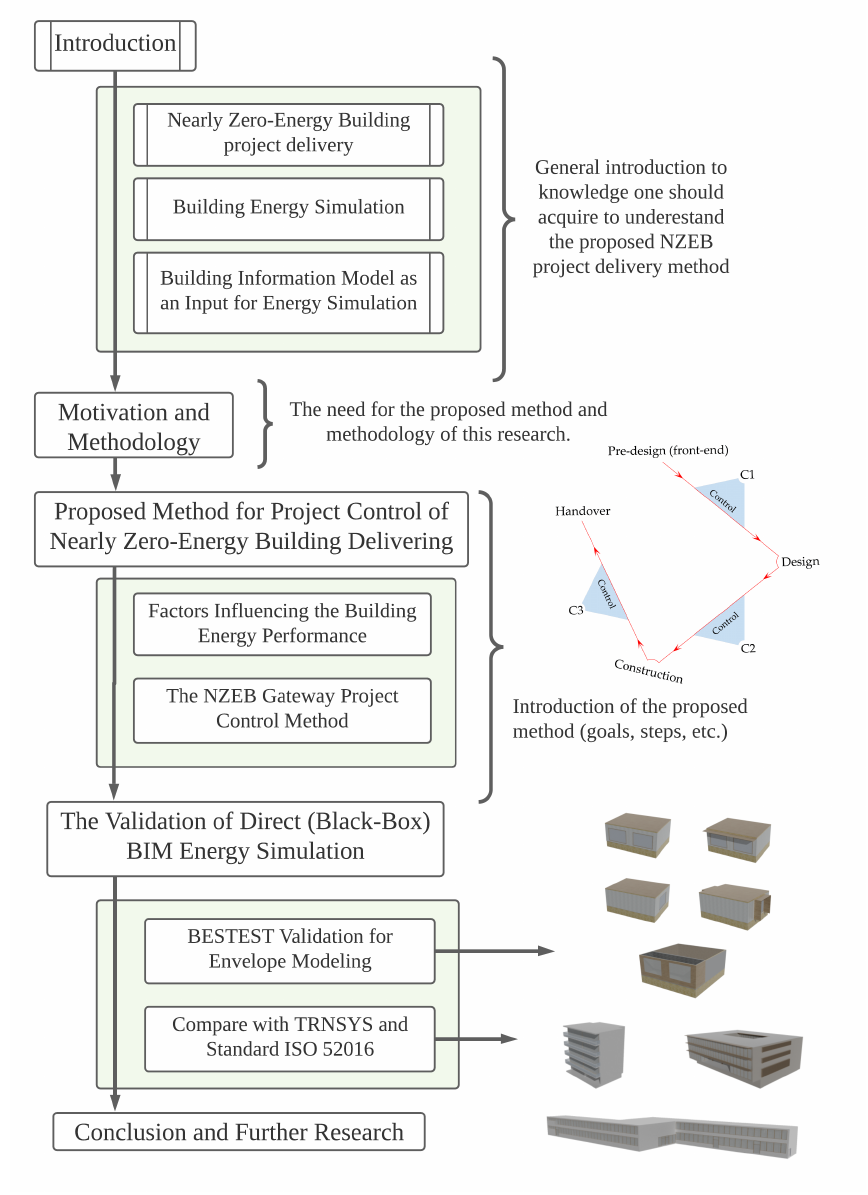
Figure 2. Framework of the paper—graphical